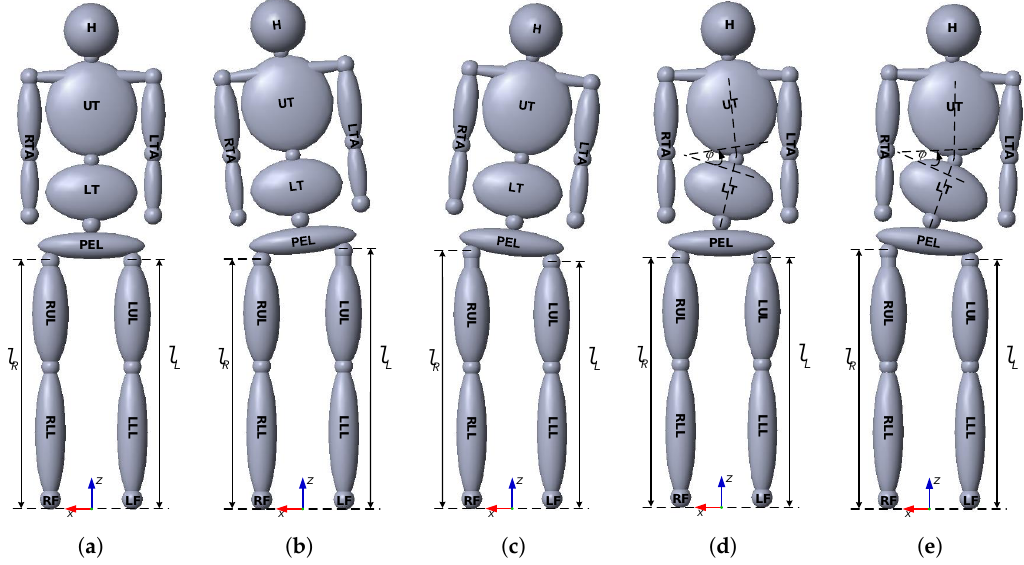
Figure 2. 12-segment anthropometric human body model with variable leg length and scoliosis (RF, Right Foot; LF, Left Foot; RLL, Right Lower Leg; LLL, Left Lower Leg; RUL, Right Upper Leg; LUL, Left Upper Leg; PEL, Pelvis; LT, Lower Trunk; UT, Upper Trunk; H, Head; RTA, Right Total Arm; LTA, Left Total Arm). Left leg length is given as l L , right leg length is l R , and the angle of scoliosis is φ : ( a ) human body without LLD and scoliosis ( l R = l L , φ = 0); ( b ) human body with LLD ( l R < l L , φ = 0); ( c ) human body with LLD ( l R > l L , φ = 0); ( d ) human body with scoliosis ( l R = l L , φ > 0); and ( e ) human body with LLD and scoliosis ( l R > l L , φ >